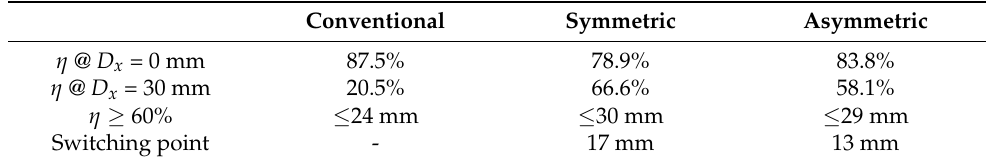
Table 4. Summary of the measured